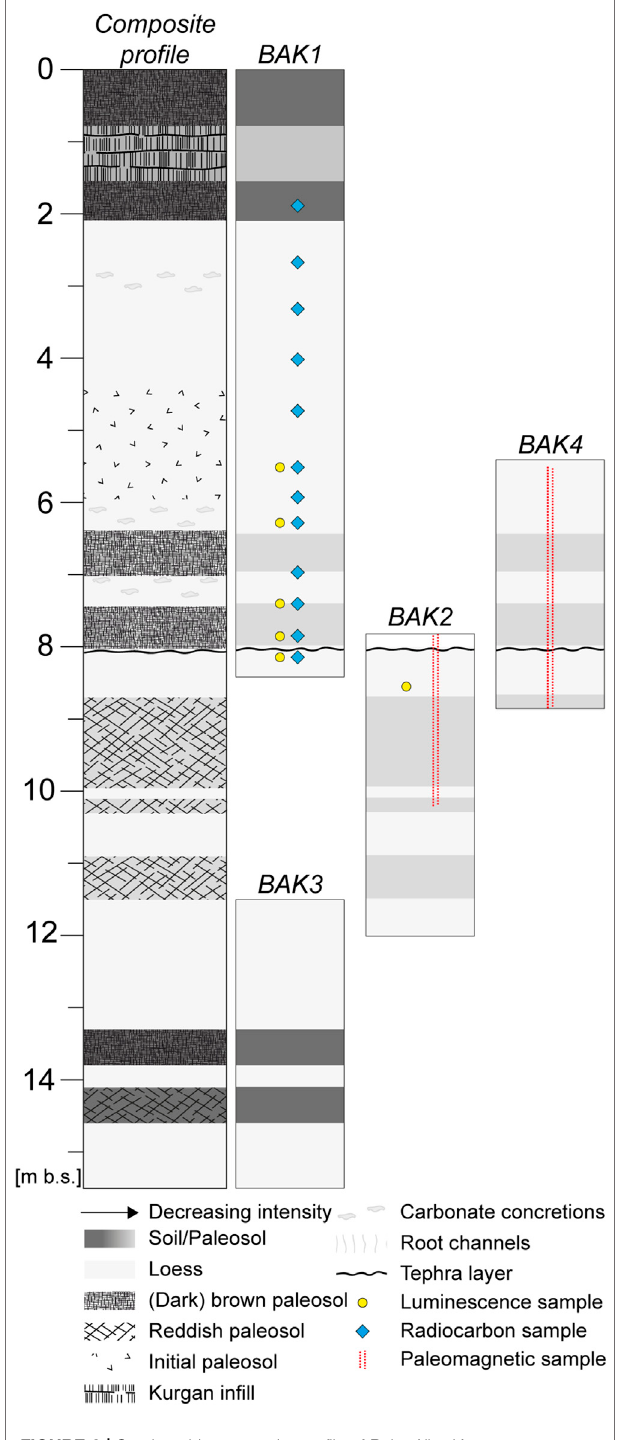
FIGURE 3 | Stratigraphic composite pro fi le of Balta Alba Kurgan. Subsections BAK1 to BAK4 are shown with stratigraphic overlap and simpli fi ed stratigraphic information. The depth is given in meters below the surface (m b.s.) of the main pro fi le (BAK1-BAK3).